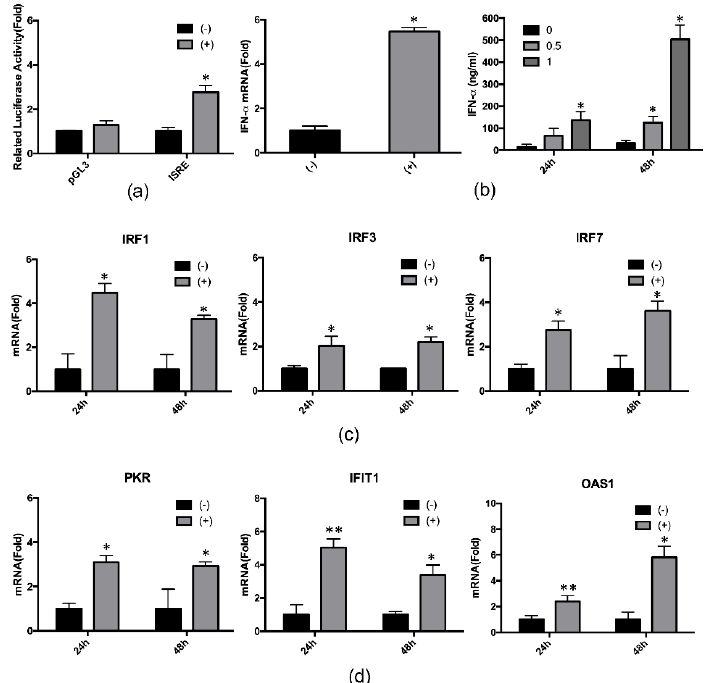
Figure 4. 4-PBA enhanced IFN-related gene expression. ( a ) Huh 7.5-Con1 cells were transfected with the empty pGL3 vector or with ISRE constructs and then incubated with or without 1 mM 4-PBA for 24 h. Luciferase activity was expressed relative to that in untreated cells. ( b – d ) After treatment with 1 mM 4-PBA for 24 h, ( b , left ) IFN- α , ( c , left ) IRF1 , ( c , middle ) IRF3 , ( c , right ) IRF7 , ( d , left ) PKR , ( d , middle ) IFIT1 , and ( d , right ) OAS1 mRNA levels were analyzed by real-time RT-PCR. ( b , right ) Huh 7.5-Con1 cells were incubated with 1 mM 4-PBA for 24 h. The medium was changed to serum-free DMEM during the 24-h incubation. After incubation, supernatants were harvested and analyzed using IFN- α -specific ELISAs. Data are expressed as means ± SDs of five independent experiments. * P < 0.05, ** P < 0.01 versus the untreated